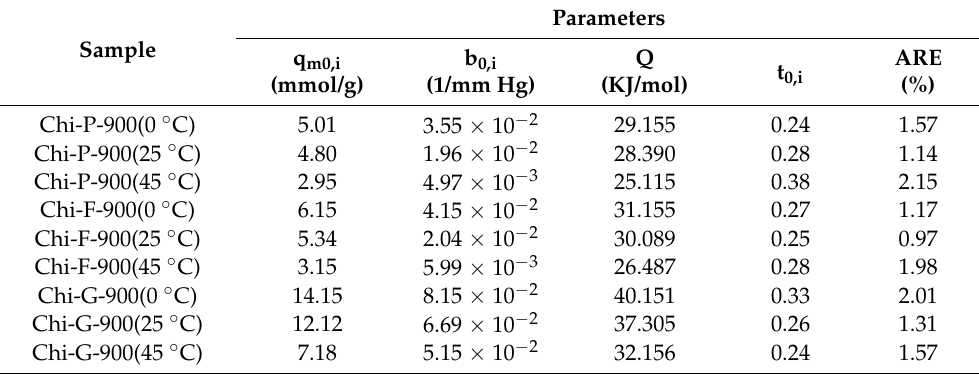
Table 4. Toth model parameters for the CO 2 adsorption of the biochars obtained after the pyrolytic treatment of chitosans with different textural properties at 900 ◦ C (CO 2 adsorption: 0–45 ◦ C).